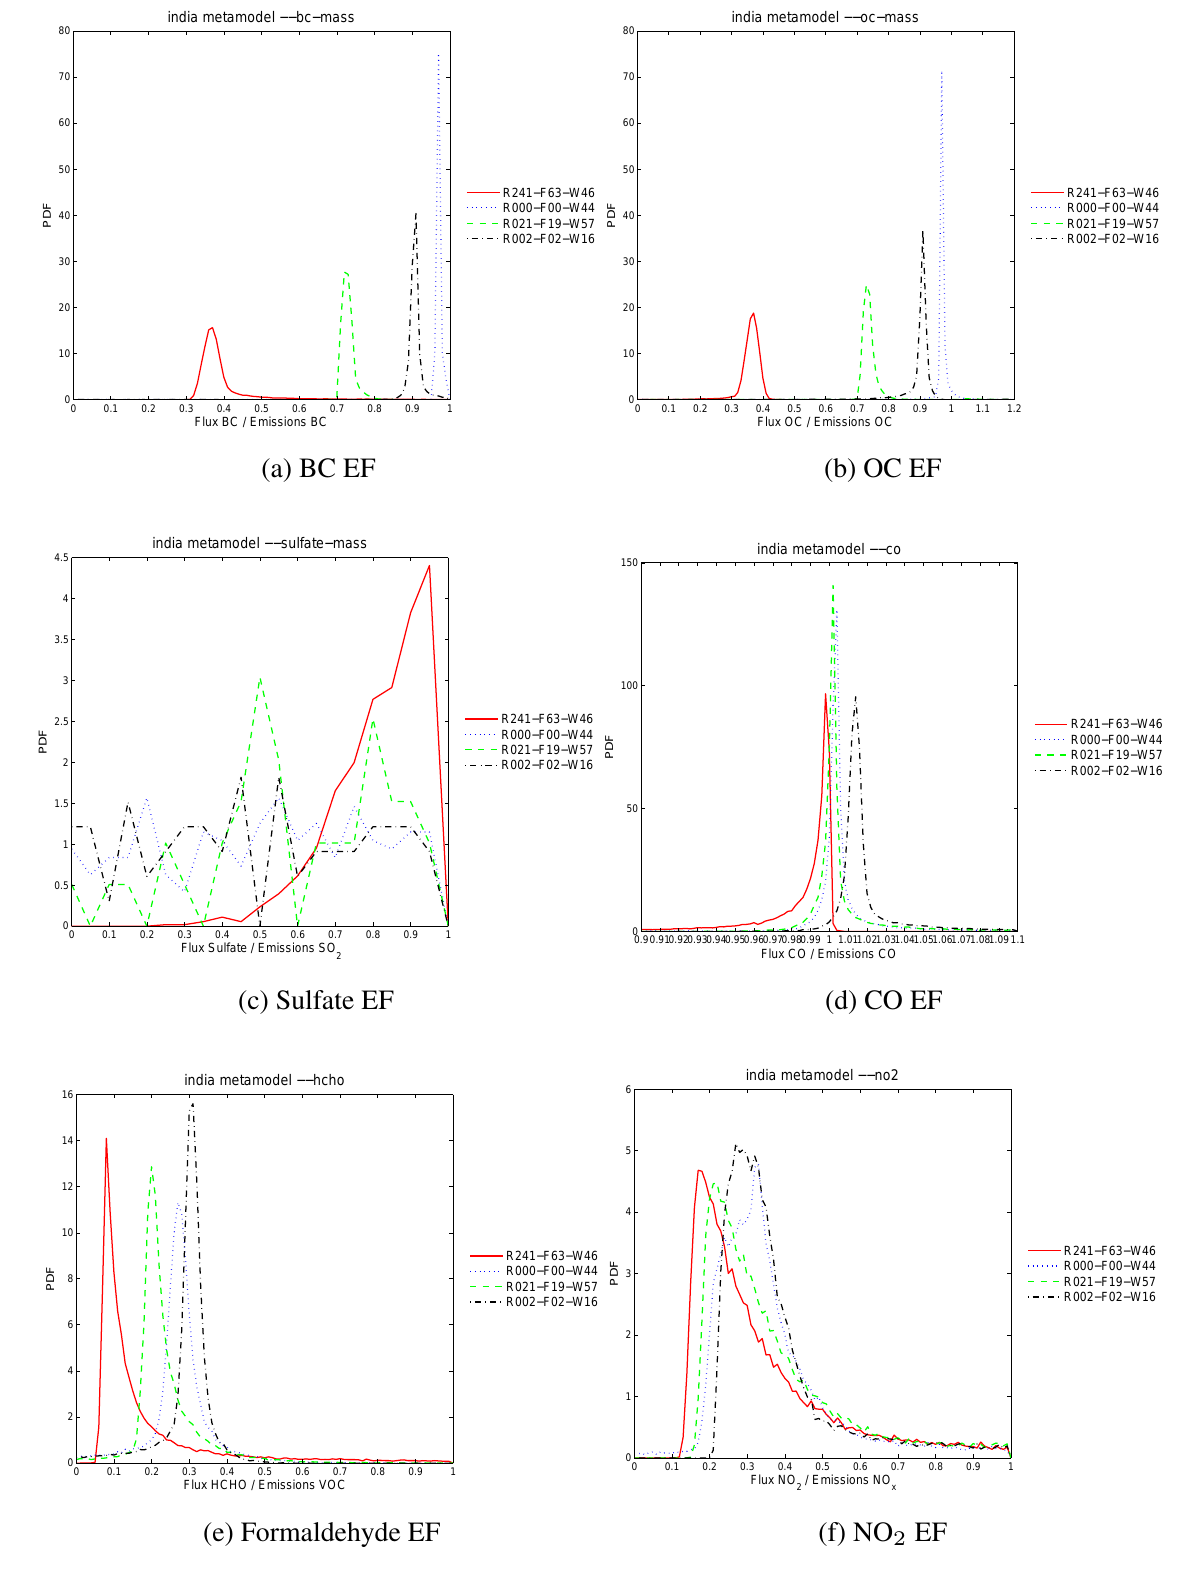
Fig. 9. These are the PDFs of the total urban area EFs (Eq. 8), from the India metamodel. For inputs, please refer to Fig. 5. Fig. 9: These are the PDFs of the total urban area EFs 8, from the India metamodel. For inputs, please refer to Figure 5 www.atmos-chem-phys.net/11/7629/2011/ Atmos. Chem. Phys., 11, 7629–7656,